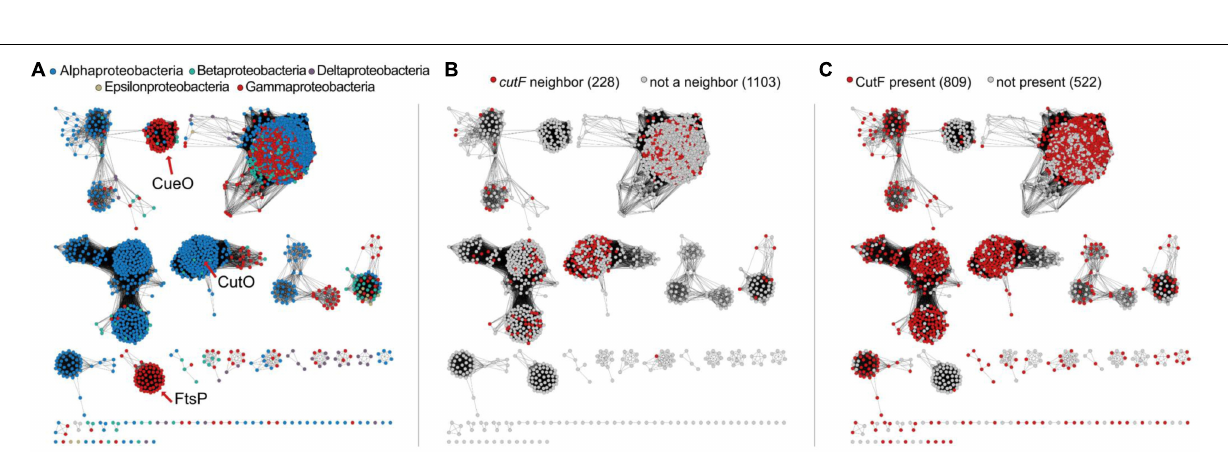
FIGURE 7 | Identification of CutF-like proteins in publicly available sequenced genomes. (A) Sequence logo representing profile hidden Markov model (from the 10th iteration of jackhammer) used to identify CutF-like sequences. (B) Multiple sequence alignment as viewed with Jalview (Waterhouse et al., 2009) of identified CutF-like sequences from R. capsulatus and Rhodobacter sphaeroides . The color scheme used is that of clustalx, and the UniProt protein IDs are indicated as labels. The quantitative alignment annotations below the alignment displayed as histograms are automatically calculated by Jalview for each column. (C) Genomic context of identified CutF-like sequences from R. capsulatus and R. sphaeroides . “Neighborhood” refers to genes likely in an operon with the gene encoding the CutF-like protein. Genes are colored according to identified Pfam domains shown at the bottom of the figure.